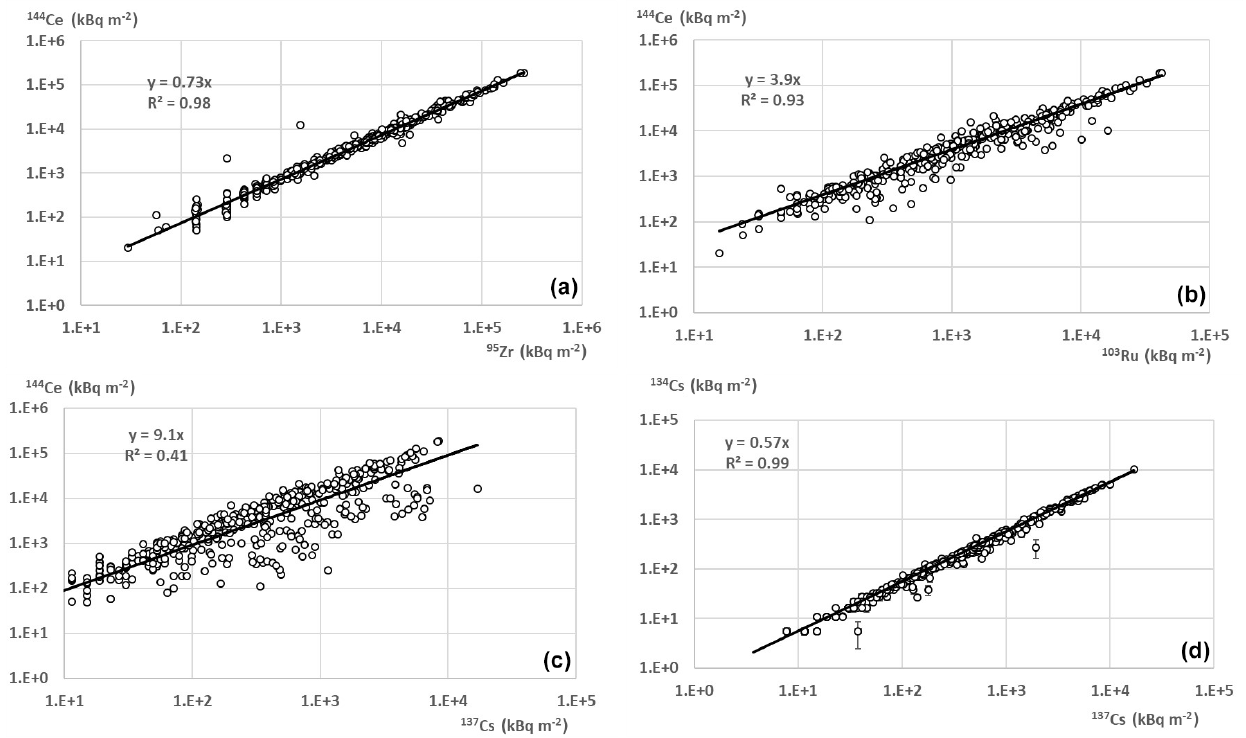
Figure 7. Correlation between deposition densities of different radionuclides decay corrected to 6 May 1986.